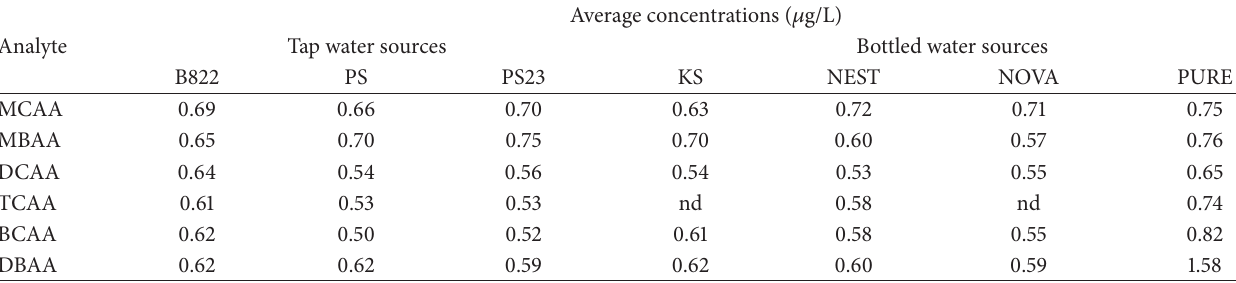
Table 3: Application of the proposed method on bottled water and tap water